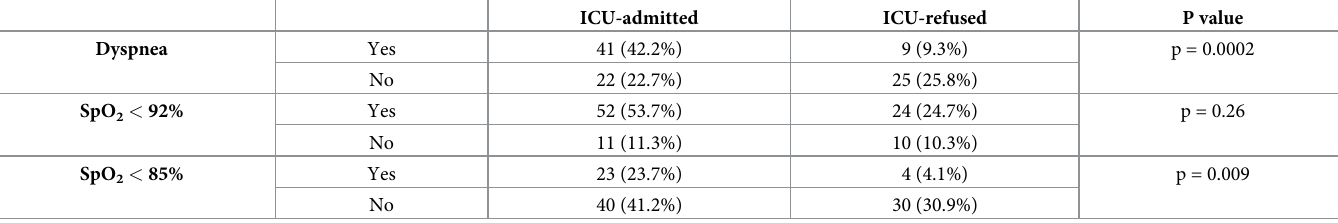
Table 2. Patients’ distribution at